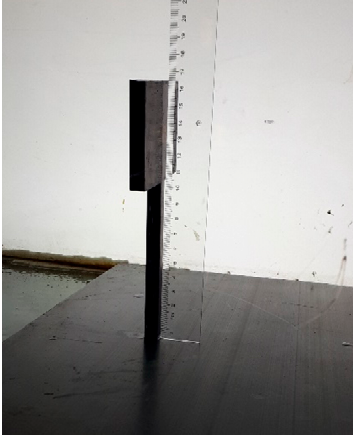
Figure 3. Standardization test.